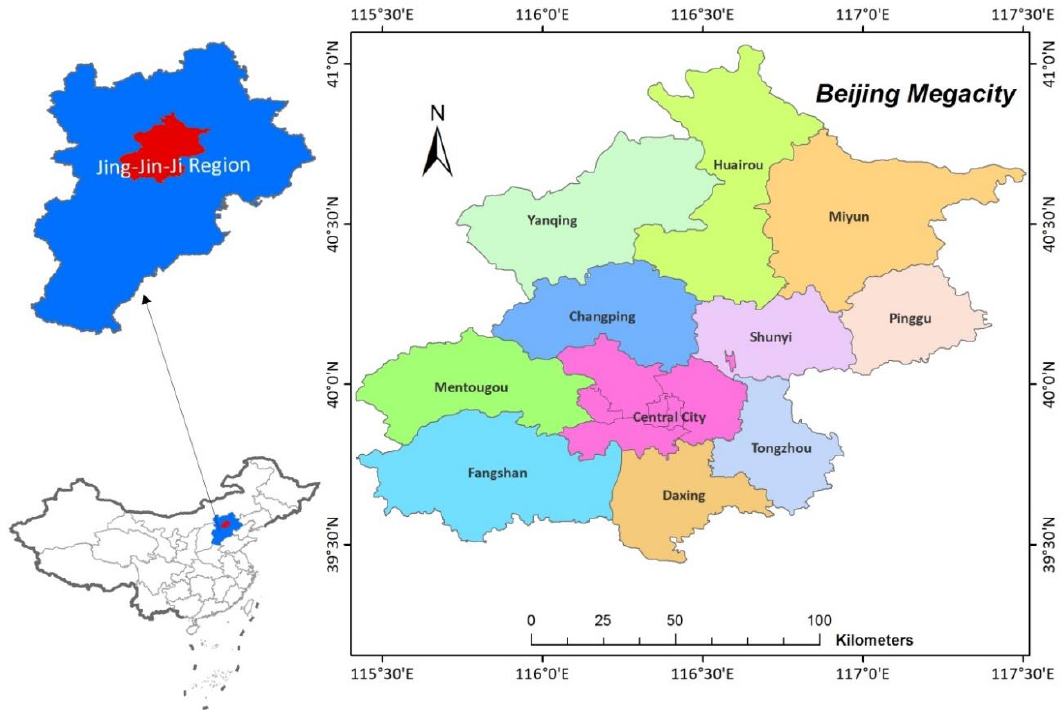
Figure 1. The geographical location and administrative map of the Beijing megacity in China.